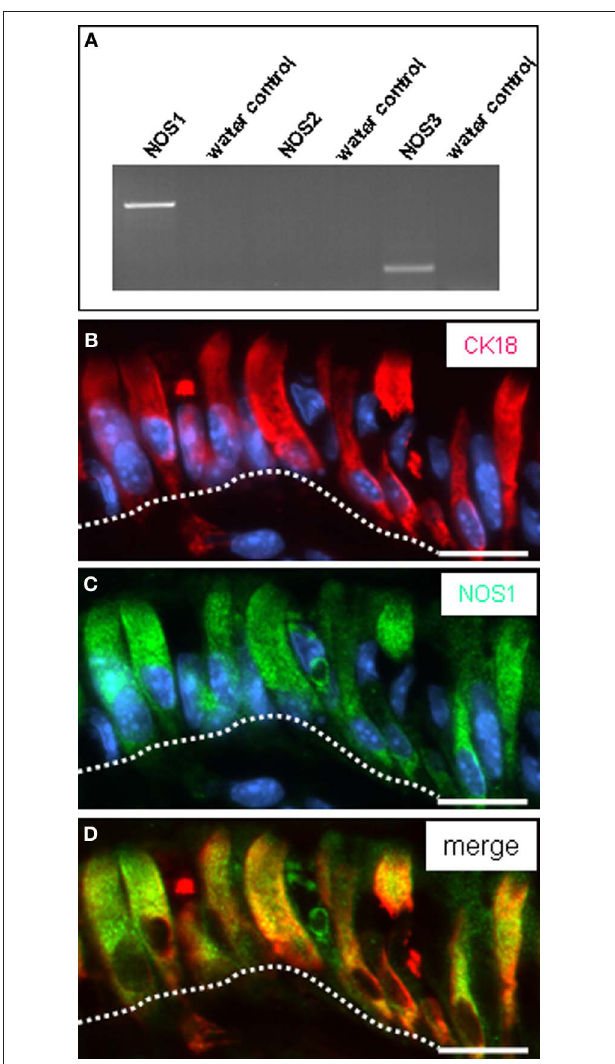
FIGURE 5 | Expression of NO-synthase 1 (NOS1) in brush cells. (A) Identification of mRNA for NOS isoforms in the corpus mucosa. Semi-quantitative RT-PCR experiments for NOS1 (680bp), NOS2 (499bp), and NOS3 (167bp) yielded amplicons of the expected size from cDNA of tissue of the fundus/corpus transition zone. While no or rather only a weak band was obtained for the isoforms NOS2 and NOS3, a strong band was amplified for NOS1. (B–D) Double-immunolabelingemploying antibodies against CK18 (red) and NOS1 (green) on corpus tissue sections. The NOS1 antibody (C) labels numerous corporal surface cells (delineated by the white dotted line ). Co-staining with CK18 antibody reveals that all CK18-positive cells are immunoreactive for NOS1 ( D ). Sections were counterstained with DAPI ( blue ). Scale bars : (B–D) = 20 μ m.